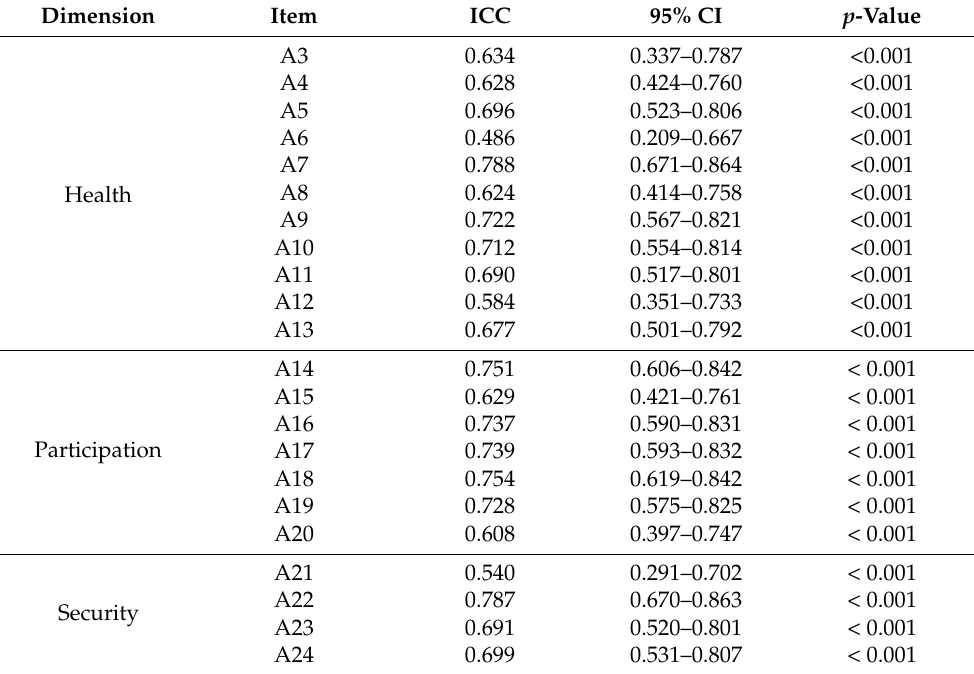
Table 3. The intra-class correlation coefficients of the items in the test-retest ( n =